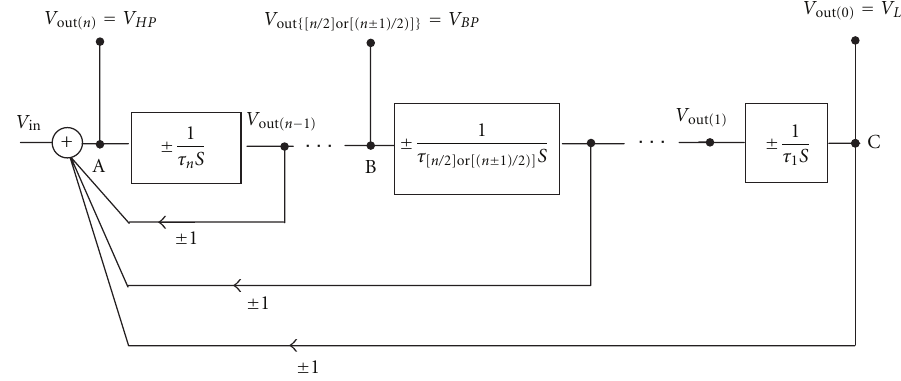
Figure 1: GFBD of the proposed generic n th order MFF topology.